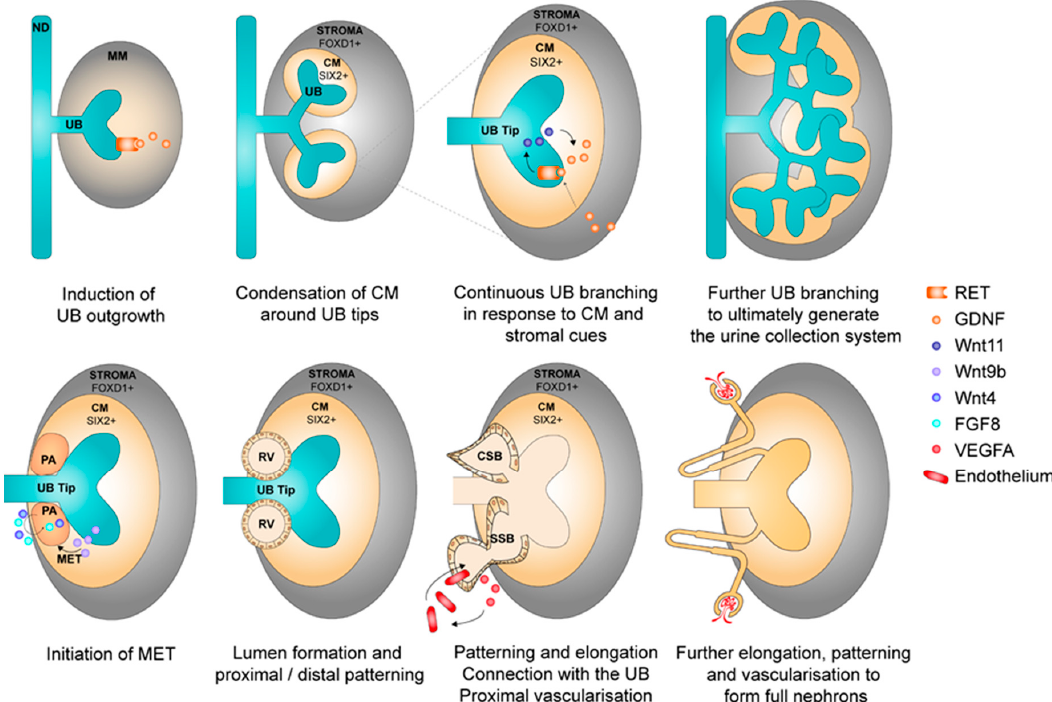
Figure 2. Brief overview of kidney development and some of the key signals that regulate specific steps. The top figures display induction and maintenance of ureteric bud branching. The bottom